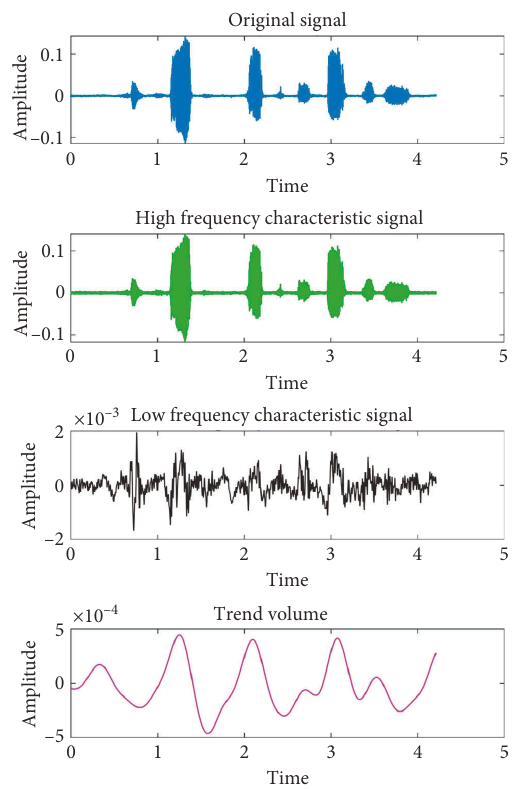
Figure 8: Frequency components of IMF components.